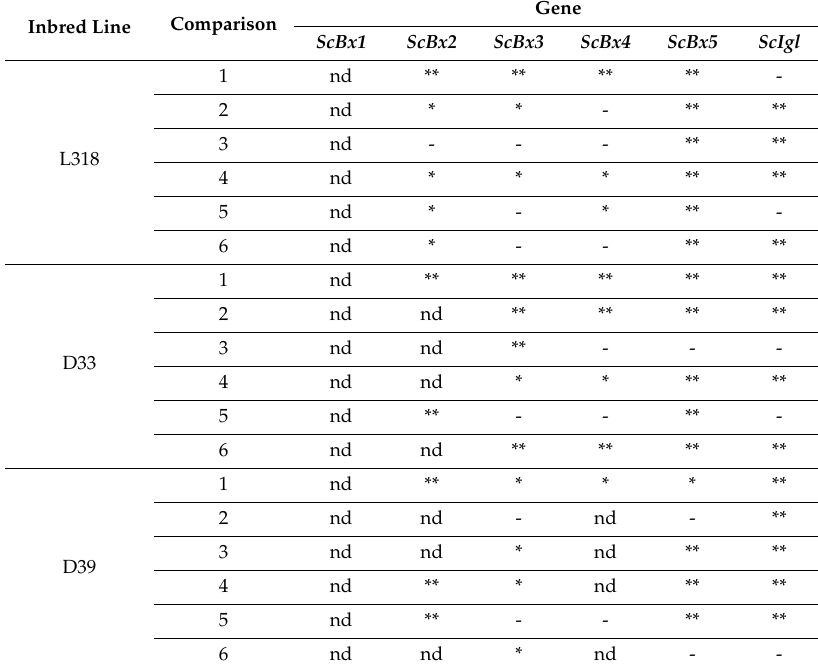
Table 2. Significance of di ff erences in ScBx1–ScBx5 and ScIgl expression levels between untreated and cold-treated plants of the rye inbred lines L318, D33, and D39 assessed using the Mann–Whitney U test.